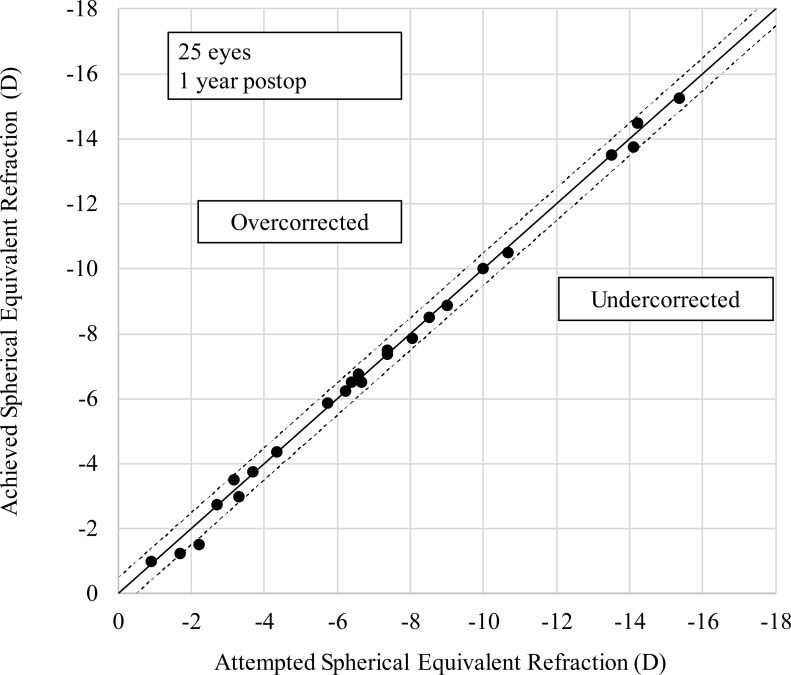
A scatter plot of attempted versus achieved correction (spherical equivalent) after implantation of an implantable collamer lens with a central hole.D = diopter.